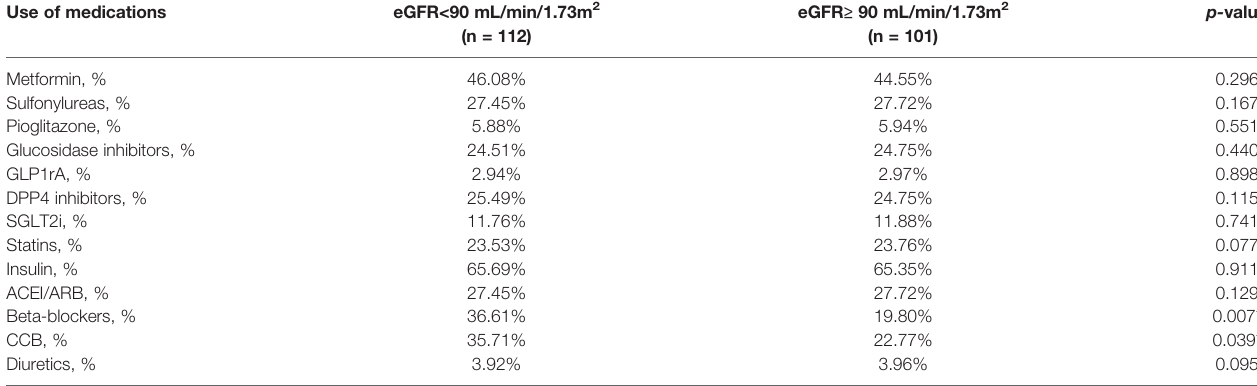
TABLE 2 | Medicine usage of T2DM patients recruited. Use of medications